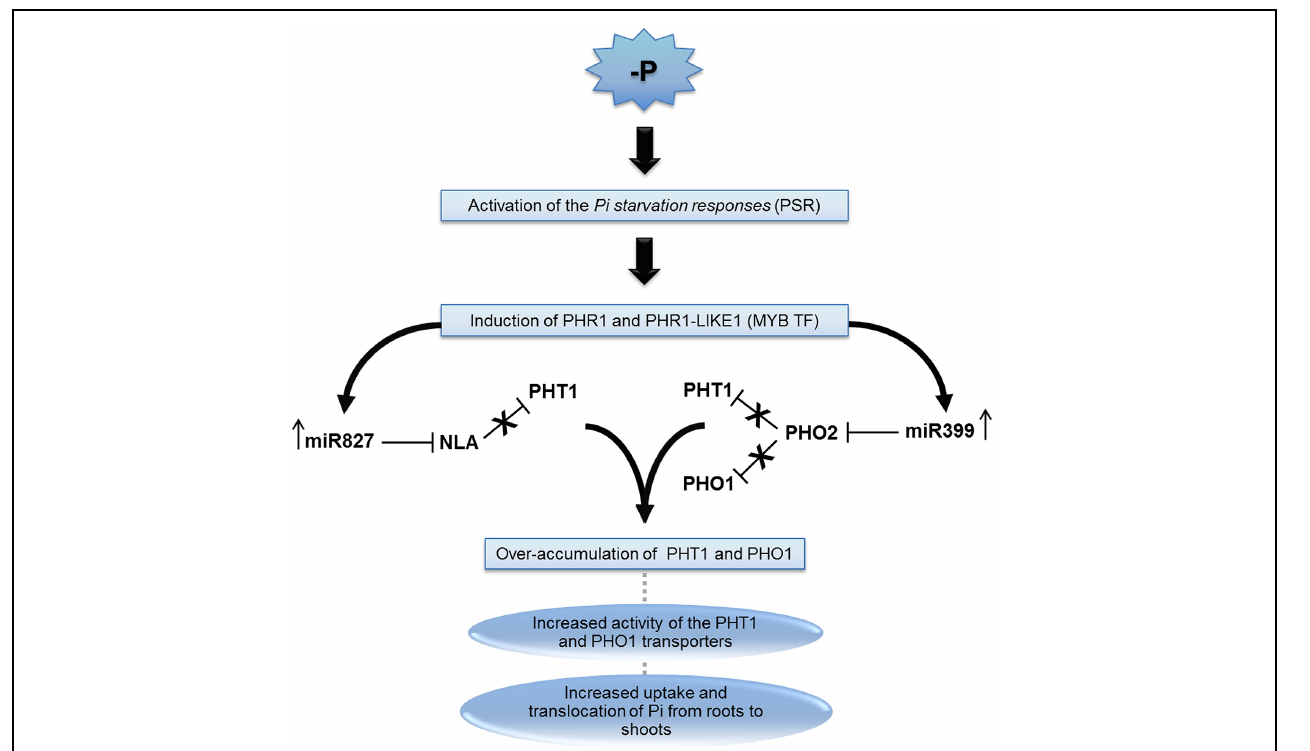
FIGURE 2 | The miRNA399 and 827 pathway involved in plant P-deficiency. Pi starvation triggers the homeostatic mechanism known as “Pi starvation responses” (PSR), which leads to induction of MYB transcription factors (MYB-TF) called Phosphate Starvation Regulator 1 (PHR1) and PHR1-like proteins. The increased levels of these proteins are related with an upregulation of miR399 and miR827. These